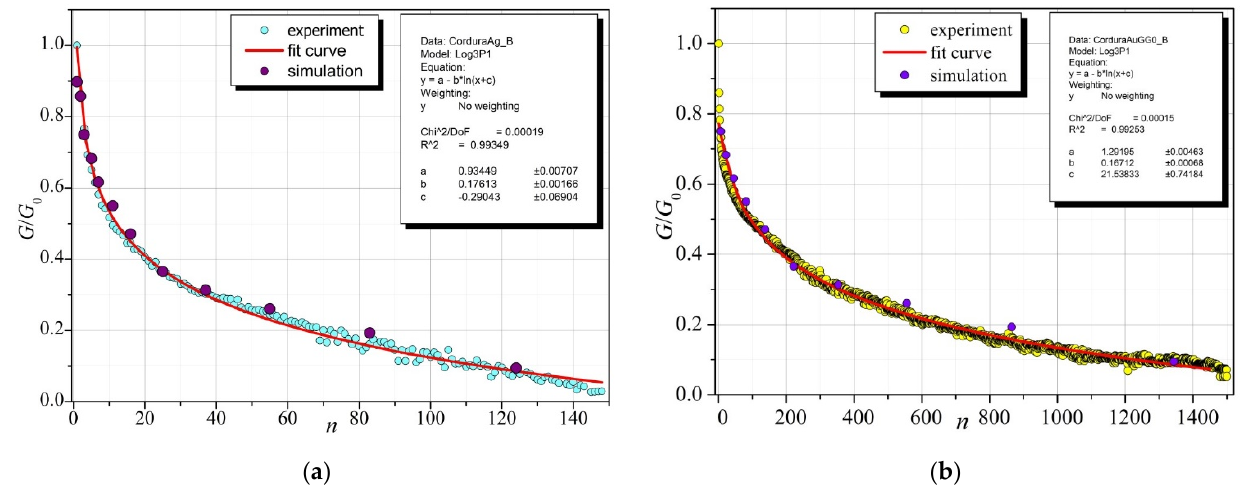
Figure 11. Comparison of experimental results with simulation results for two conductive layers on Cordura: ( a ) for Ag; ( b ) for Au. Figure 11a,b: the inset shows the values of parameters a, b, and c and statistical parameters (Chi 2 /DoF—Test Chi 2 /Degrees of Freedom; R 2 —coefficient of determination) determining the degree of matching, calculated using the OriginPro7 program (at the confidence level of 0.95).